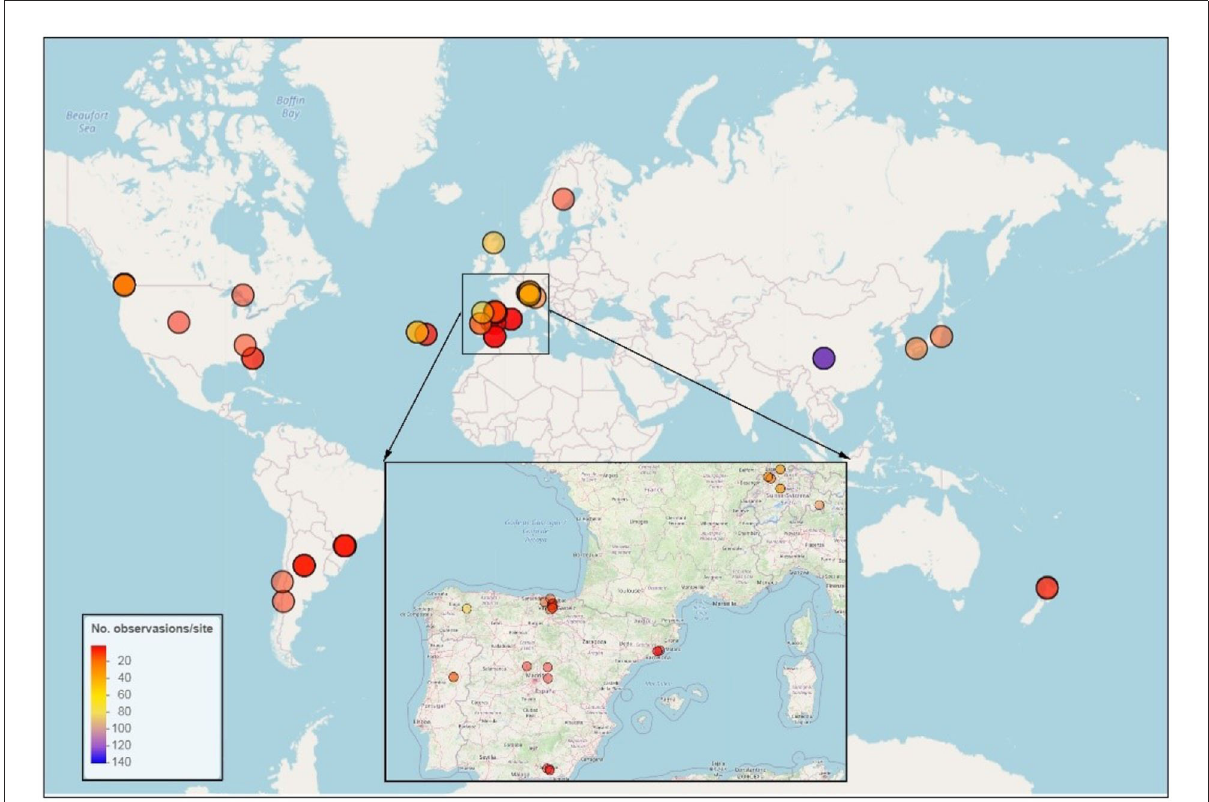
FIGURE1 Global distribution of the 54 sites of coniferous leaf-litter decomposition in streams and rivers. There were 541 and 428 records of coniferous leaf-litter breakdown rates expressed as per day and per degree day, respectively. The colors of circles represent the number of records of leaf-litter breakdown rates (including per day and per degree day) at each